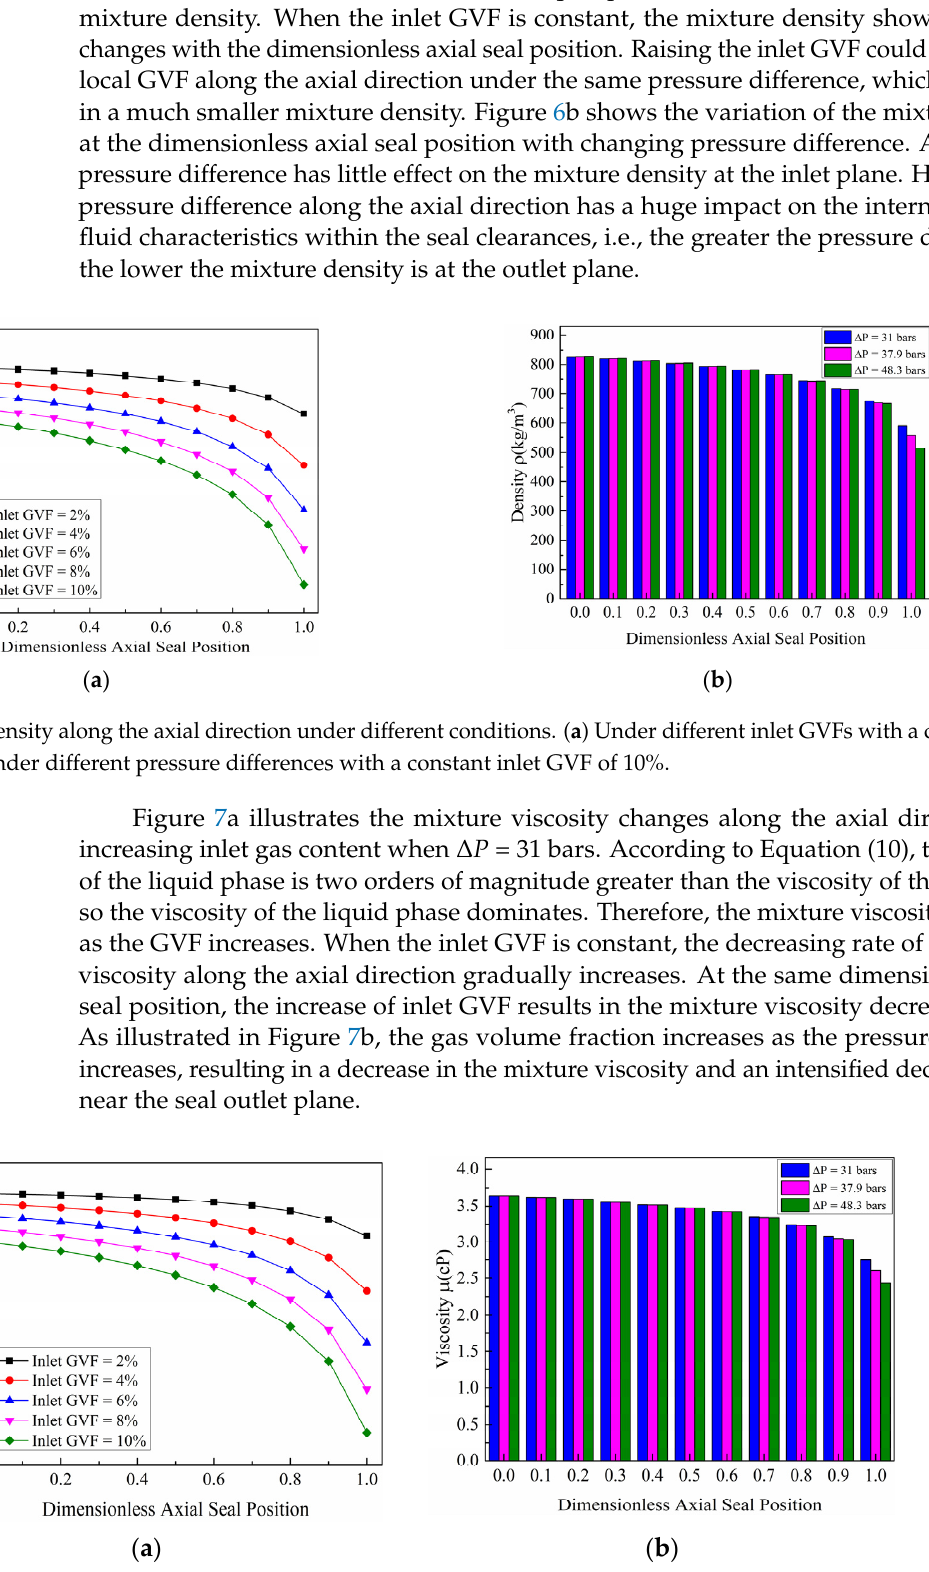
Figure 4. GVF distribution characteristics along the axial direction under different operating conditions. ( a ) GVF under different inlet GVFs for Δ P = 31 bars, ( b ) GVF under different pressure differences for inlet GVF = 10%.